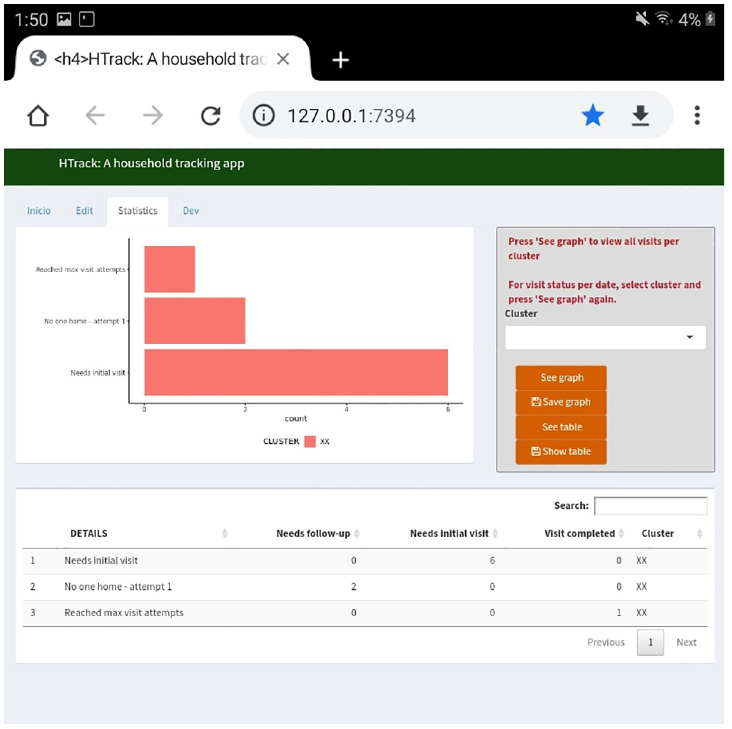
Fig 5. HTrack statistics tab serves as the data visualization area to monitor daily field progress. This area shows the current progress by cluster or overall. Graphs and tables can be downloaded as needed.